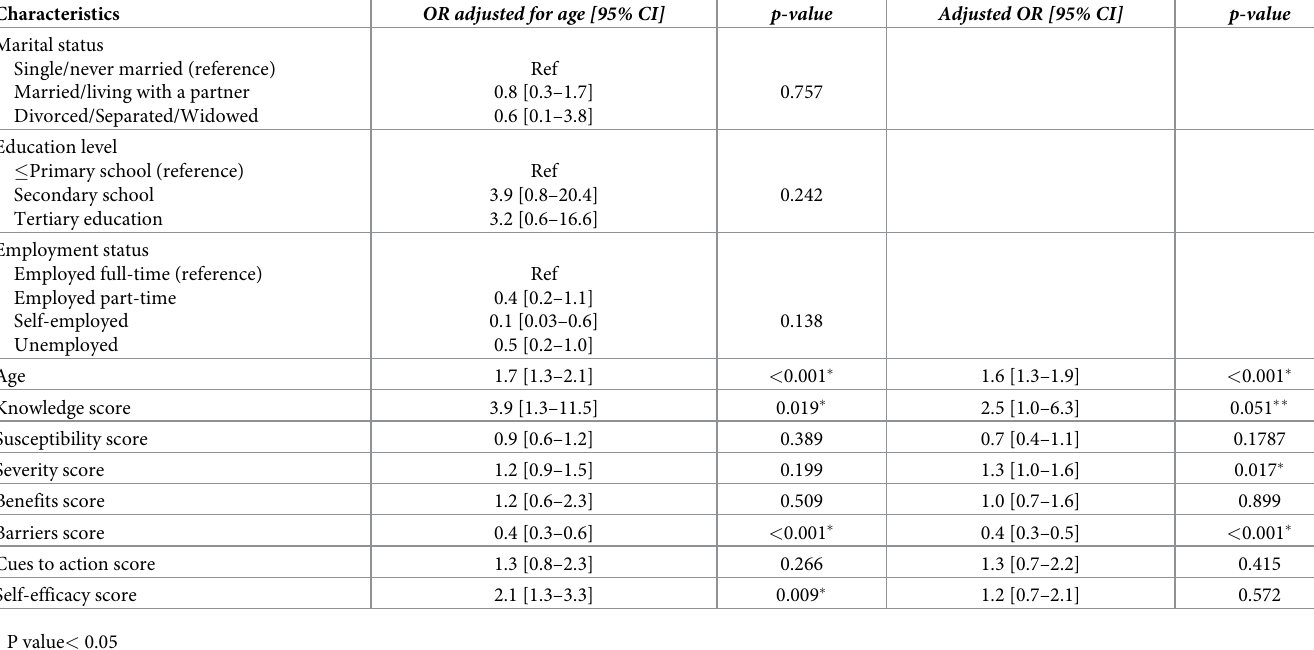
Table 3. Association between HBM constructs and Pap smear uptake, adjusting for potential confounding variables.